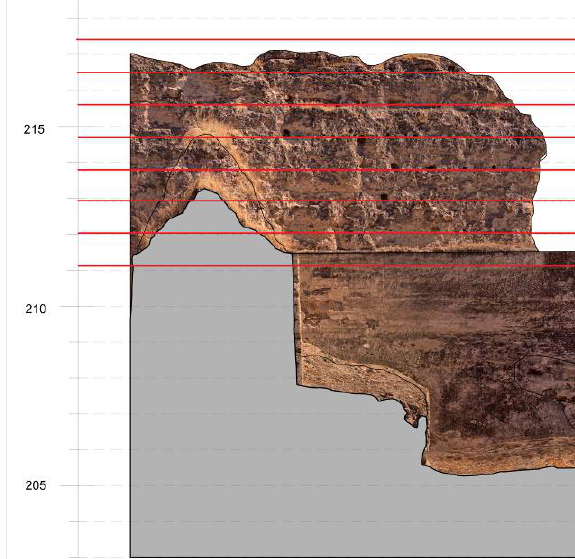
Figure 14. Image showing the metrics of the original earth